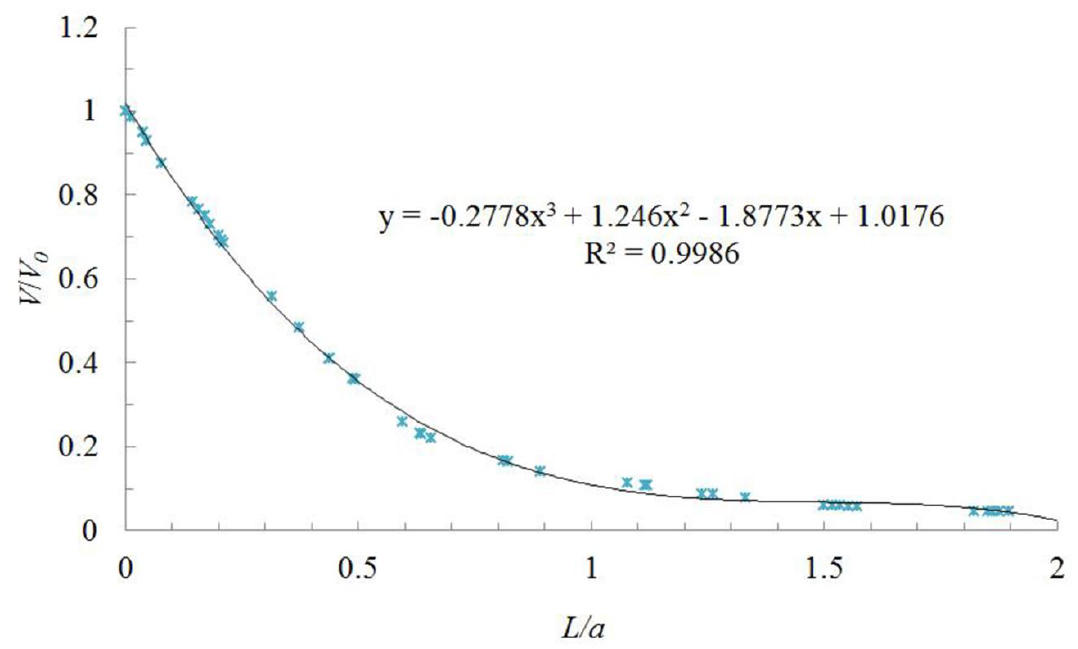
Figure 5. Dimensionless change in hood axis velocity ( V/V 0 ) for different dimensionless distances from hood face ( L/a ).